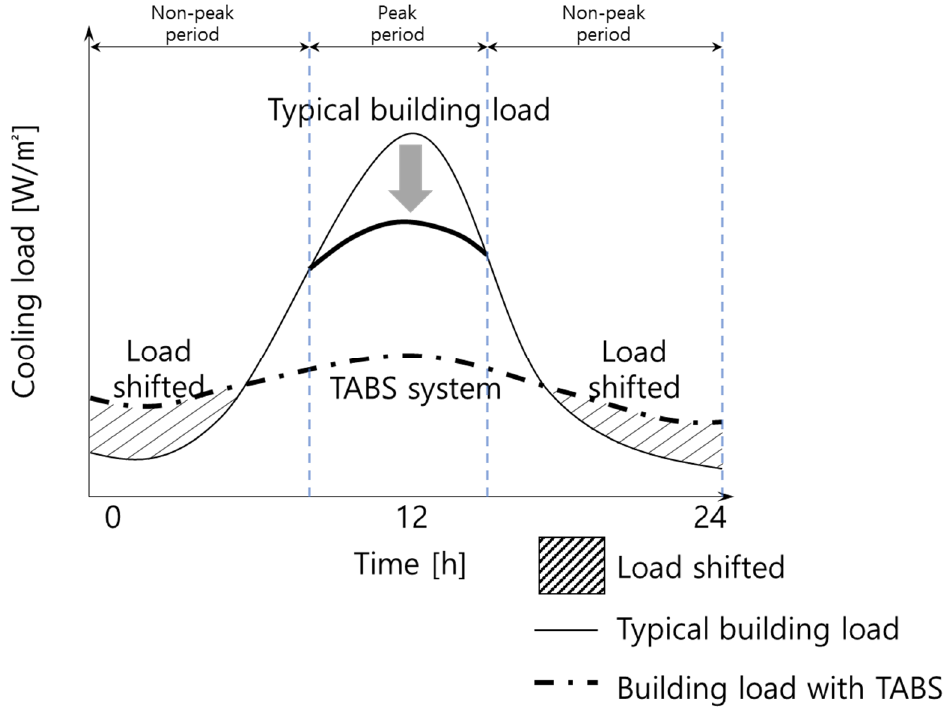
Figure 8. Concept of peak reduction by TABS.